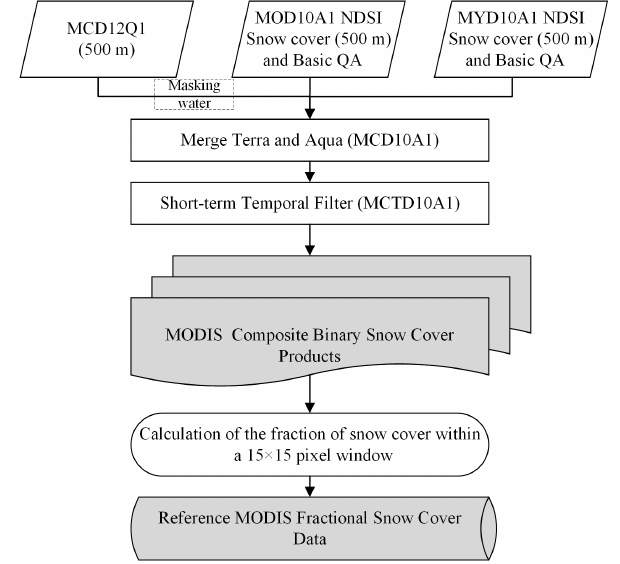
Figure 3. The generation of MODIS fractional snow